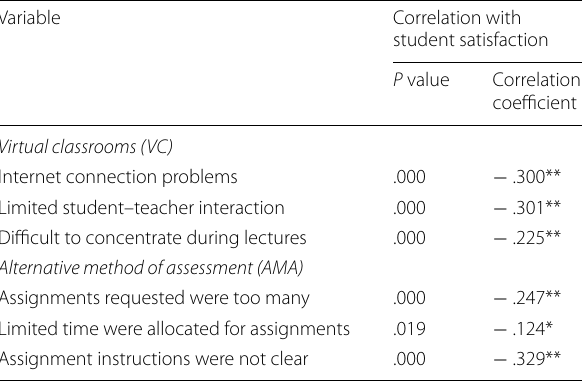
Table 2 Correlation analysis of student’s satisfaction with the institution performance in managing educational processes during the COVID-19 lockdown and responses to questions from Fig.